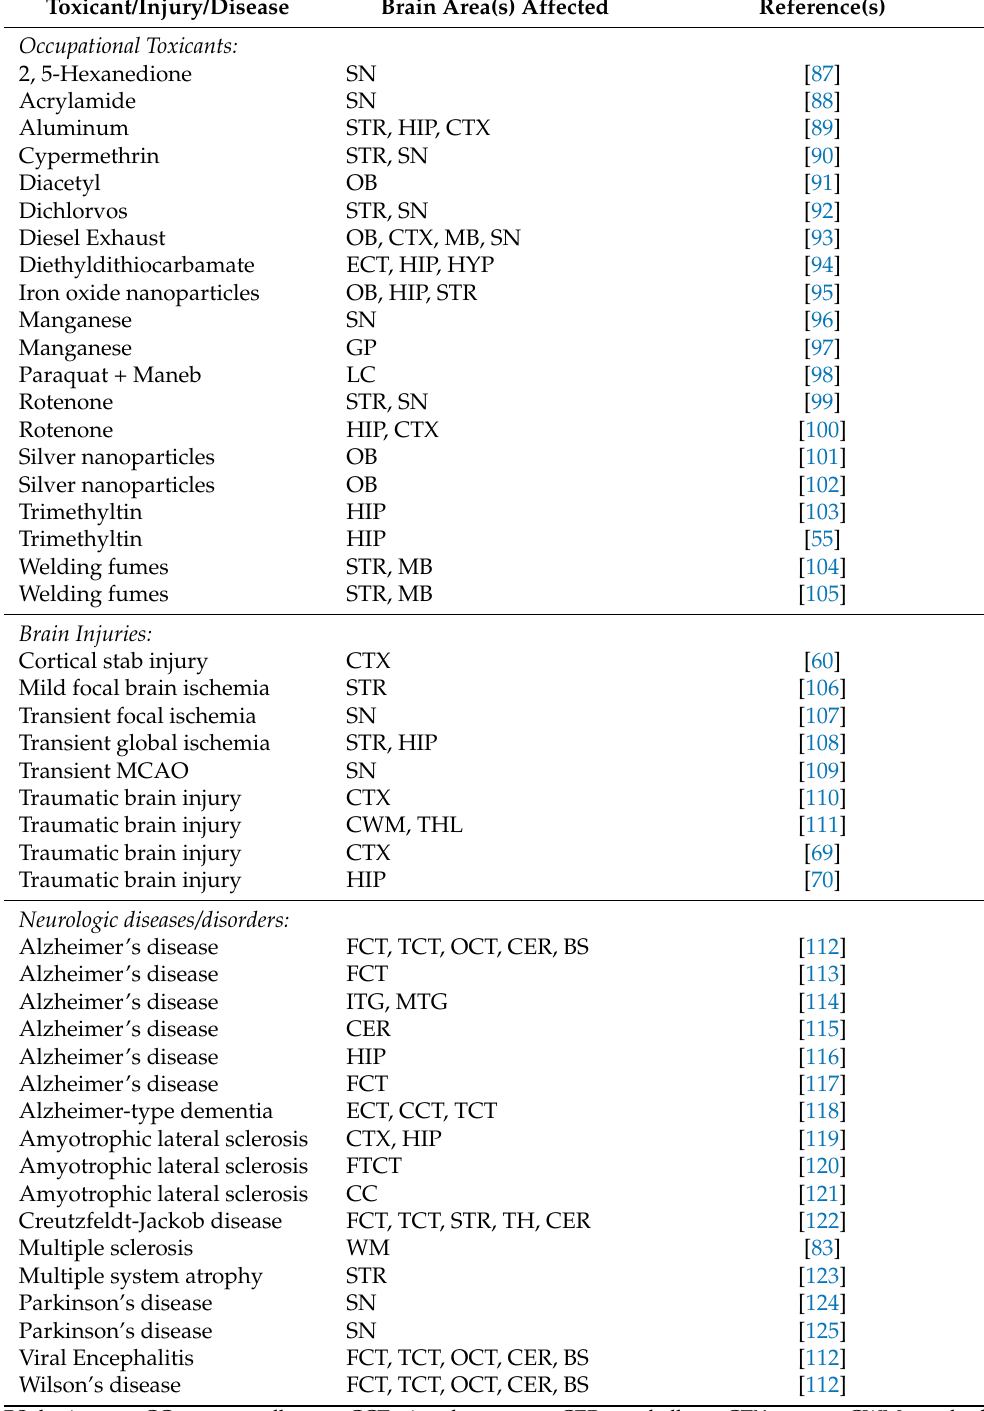
Table 2. Microglial activation associated with occupational toxicants, brain injuries, and neurologi- cal